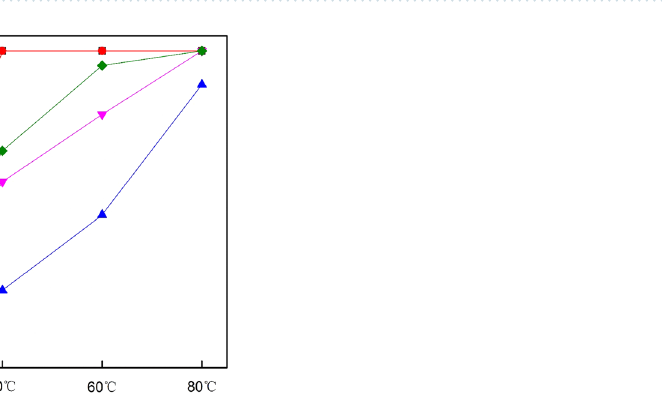
Figure 5. Leaching rate of copper in different occurrence states at different temperatures. ( a ) Copper in mineral state; ( b ) Isomorphic copper; ( c ) Adsorbed copper; ( d ) Copper in cemented body; ( e ) Other bound copper.